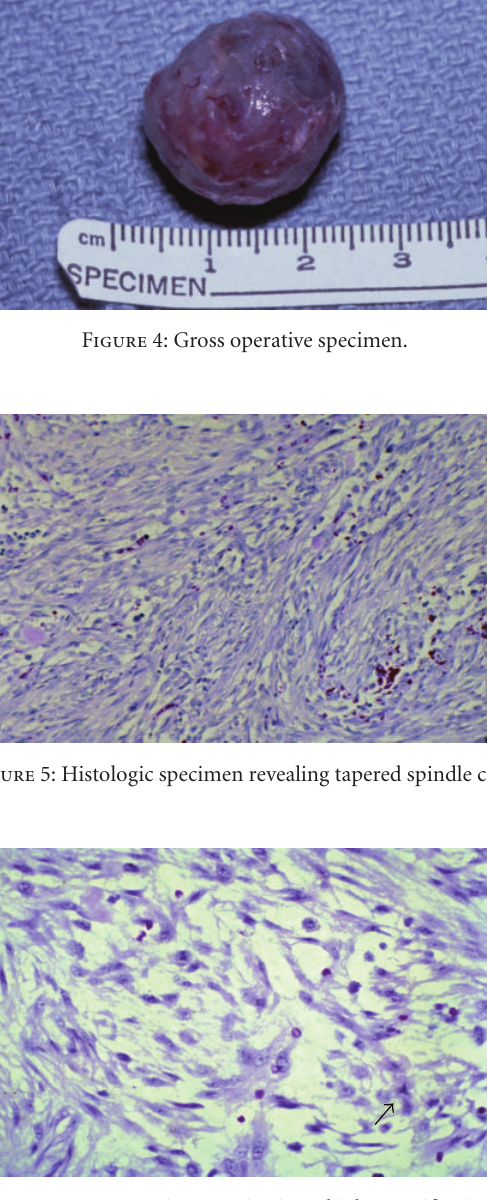
Figure 6: Arrow points to mitosis on high